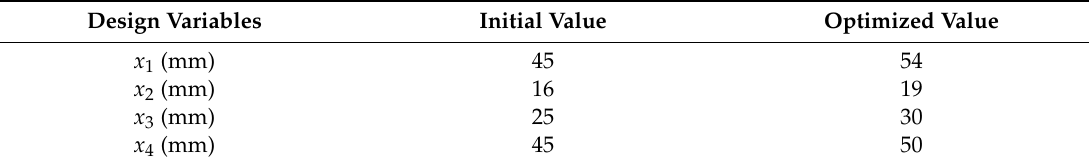
Table 9. Comparison of the initial and optimized design variables.